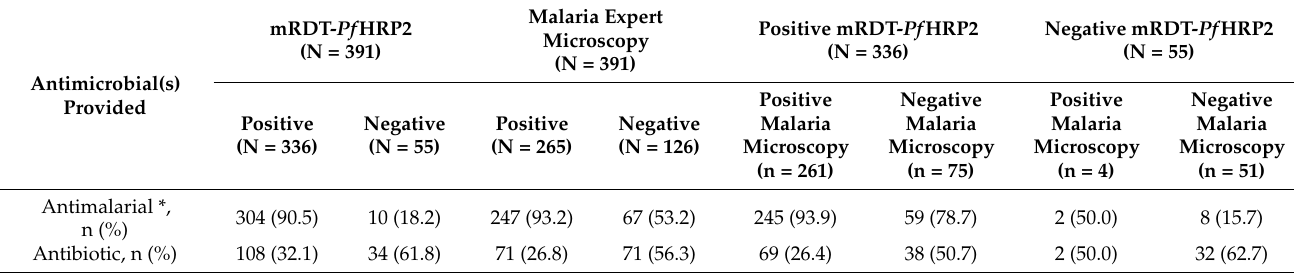
Table 3. Antimicrobial treatment provided at the recruitment sites combined with malaria diagnostic test results using RDTs and malaria expert